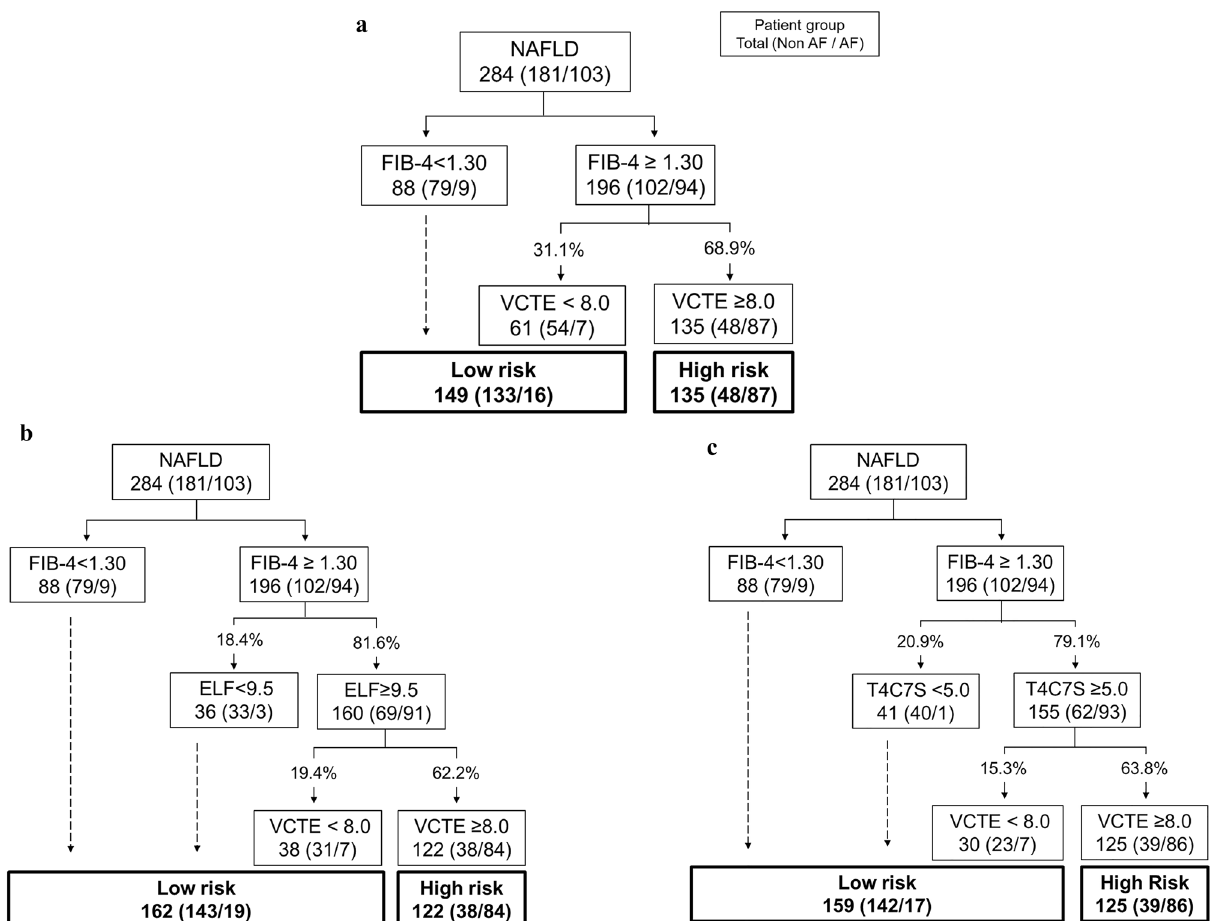
Figure 1. Performance of each approach in the tertiary care center cohort. Number and percentages of patients evaluated using the ( a ) 2-step approach, ( b ) 3-step approach with ELF, and ( c ) 3-step approach with T4C7S. The numbers in the boxes and parentheses are the sum of the total patients and the number of patients without advanced fibrosis/number of patients with advanced fibrosis, respectively. The numbers on the lines are the percentages among patients with a FIB-4 score of ≥ 1.30. AF, advanced fibrosis; ELF, enhanced liver fibrosis test; FIB-4, Fibrosis-4 index; T4C7S, type IV collagen 7S domain; VCTE, vibration-controlled transient elastography.